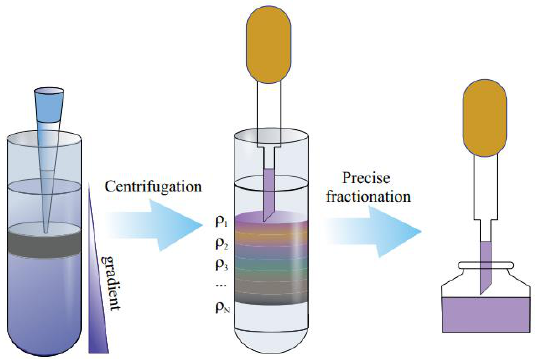
Figure 17. Schematics for the separation of SWCNTs using the density gradient ultracentrifugation technique. SWCNTs that have not been sorted are put into a centrifuge tube that has a mass density gradient at the isopycnic sites of the materials. Surfactant-wrapped SWCNTs move across a gradient to form separate colored layers during ultracentrifugation as a result of a conflict between the applied centrifugal force and the resulting opposing buoyant force. For the collection of chirality-enriched layers, a precise fractionation is necessary.